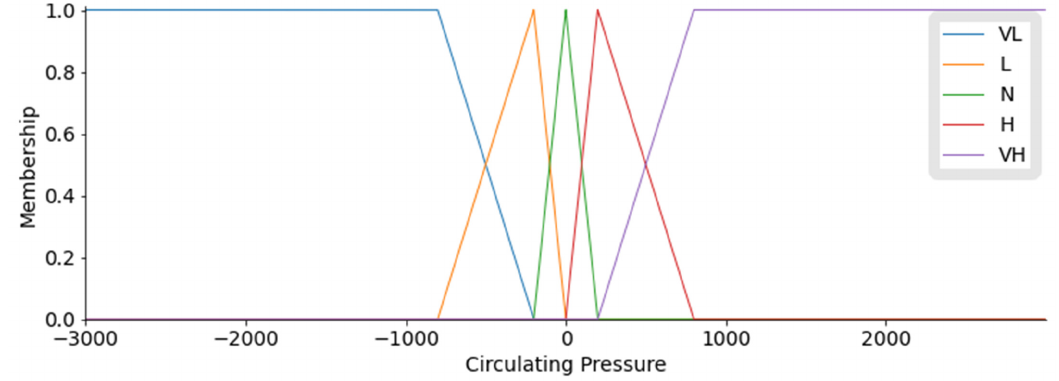
Table 1. Membership functions for variable delta_CP ( ∆ (cid:3004)(cid:3017) ).